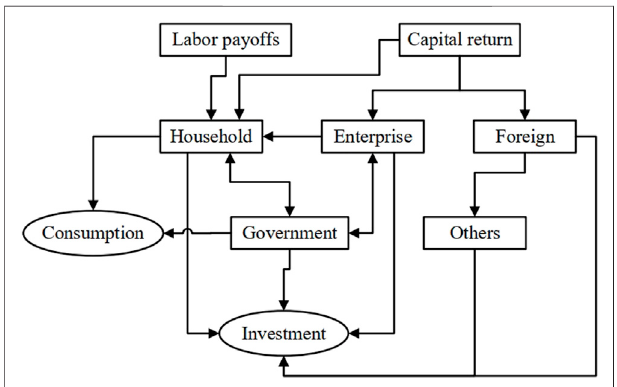
FIGURE 4 | Flow direction of each